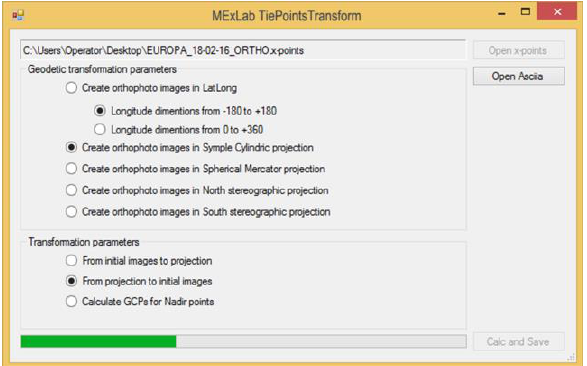
Figure 3. User interface of the module TiePointsTransform for optimization of tie-point measurements.